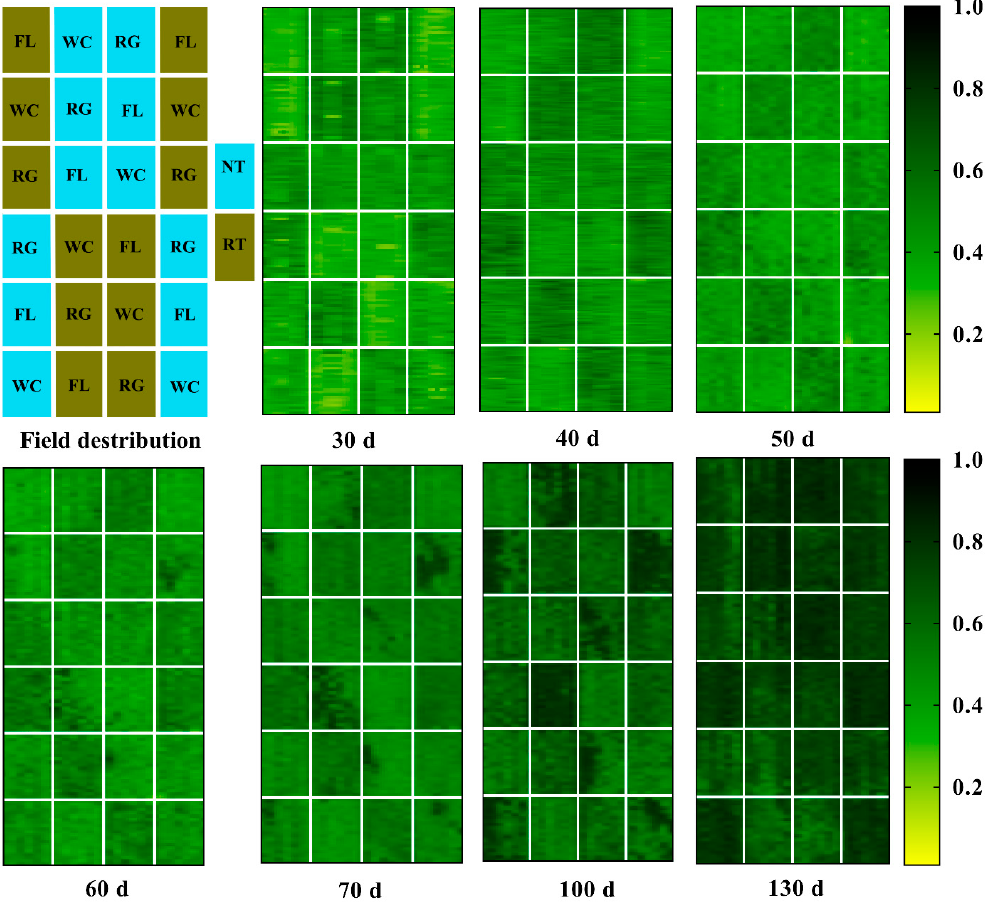
Figure 4. Change of vegetation coverage based on NDVI. NT, no − tillage; RT, rotary tillage; FL, fallow; WC, white clover; RG, ryegrass. Data was collected in different plots from 30 to 130 days after sowing.